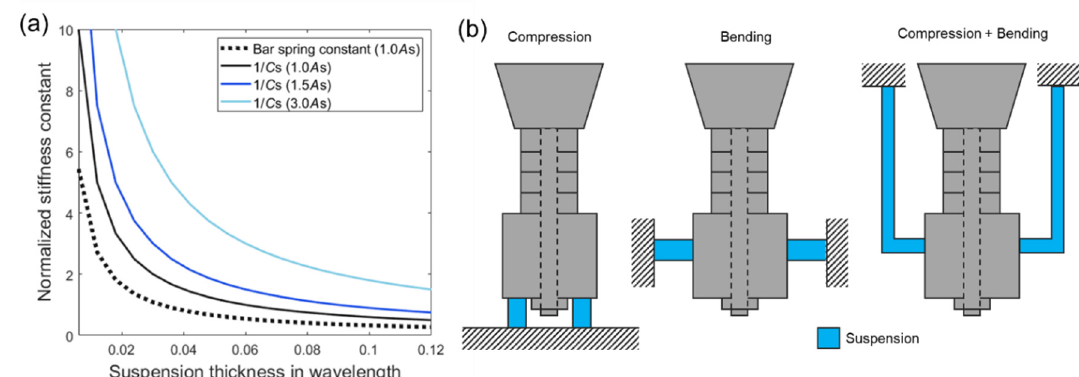
Figure 8. Material and design of a suspension: ( a ) effective stiffness as a function of suspension thickness. The larger cross-sectional areas (1.5 A s and 3.0 A s ) yield higher stiffness; ( b ) suspension design examples (4-layer stacked piezo-element as an example). The same effective stiffness can be designed by adjusting the suspension structure and material.